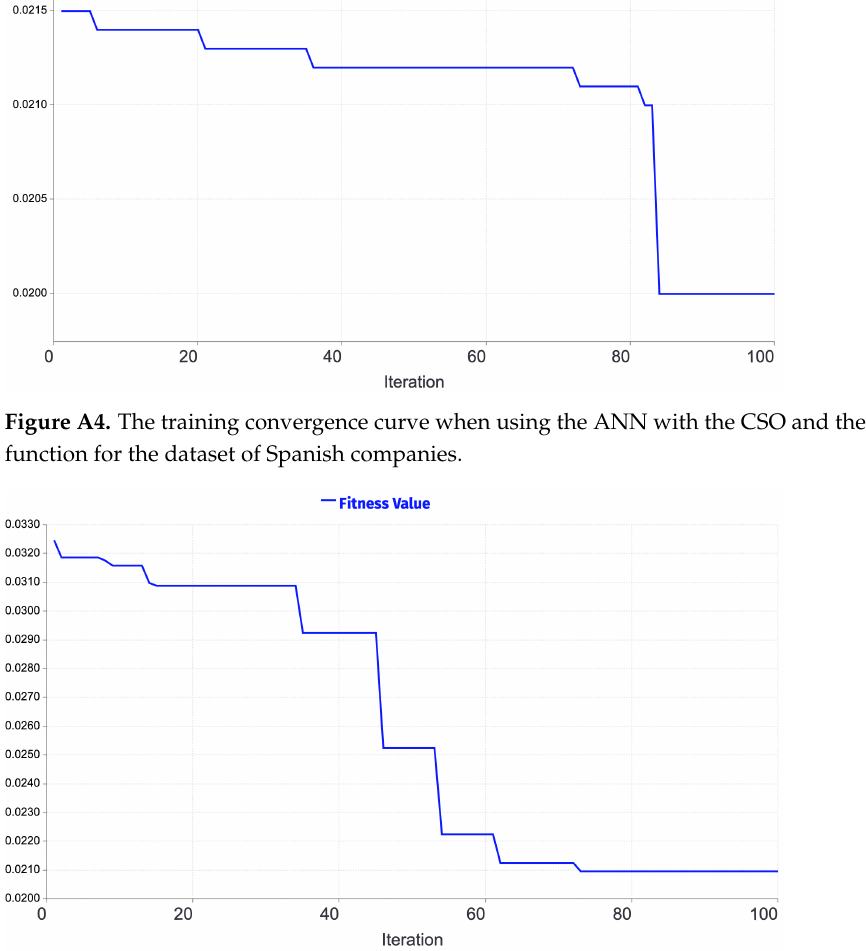
Figure A5. The training convergence curve when using the ANN with the CSO and the accuracy fitness function for the dataset of Spanish